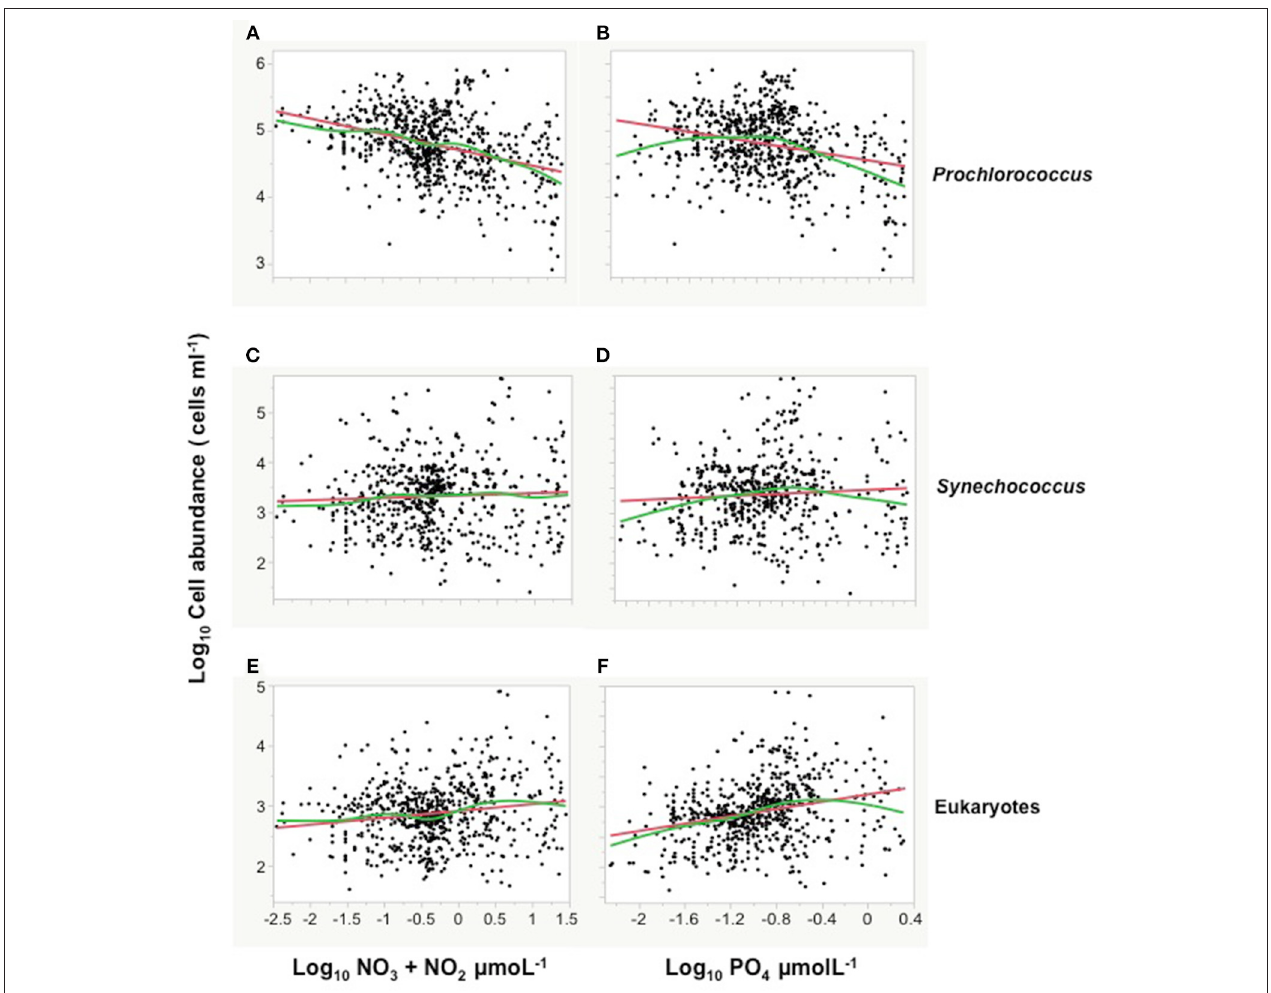
FIGURE 4 | The relationships between log picophytoplankton abundance and log NO 3 + NO 2 , and log PO 4 concentrations during the Malaspina expedition. All oceans and sampling depths are included. Each panel contains the fitted linear (red line) and smoothing spline (lambda = 1, green line) relationships. The smoothing spline fit was not used in the models for projections. (A) Prochlorococcus abundance vs. log NO 3 + NO 2 (Linear fit, R 2 = 0.14, P < 0.0001; Smoothing spline fit, R 2 = 0.172). (B) Prochlorococcus relationship with PO 4 (Linear fit, R 2 = 0.14, P < 0.0001; Smoothing spline fit, R 2 = 0.14). (C) Synechococcus abundance vs. NO 3 + NO 2 (Linear fit, R 2 = 0.002, P = 0.20; Smoothing spline fit, R 2 = 0.01). (D) Synechococcus relationship with PO 4 (Linear fit, R 2 = 0.005, P = 0.096; Smoothing spline fit, R 2 = 0.03). (E) picoeukaryotes abundance vs. NO 3 + NO 2 (Linear fit, R 2 = 0.02, P < 0.0001; Smoothing spline fit, R 2 = 0.172). (F) eukaryotes abundance relationship with PO 4 (Linear fit, R 2 = 0.075, P < 0.0001; Smoothing spline fit, R 2 =